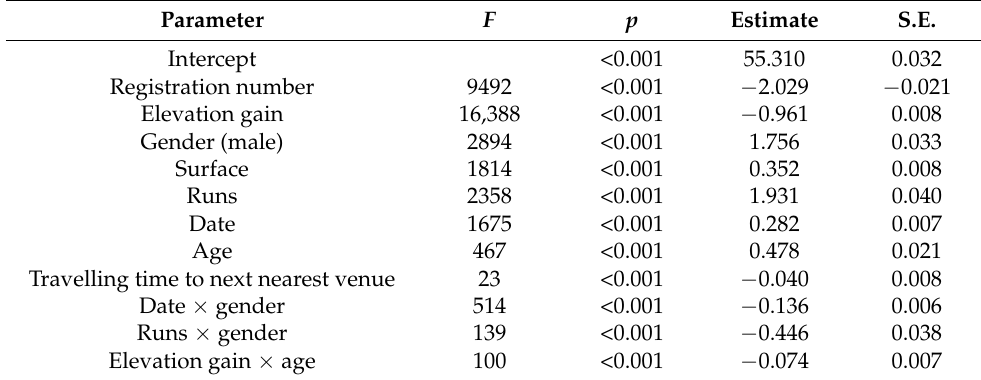
Table 2. A linear mixed model of AGPS at Scottish parkrun events. Participant was included as a random effect. The final three parameters listed in the table are significant interaction terms that were also maintained in the model.